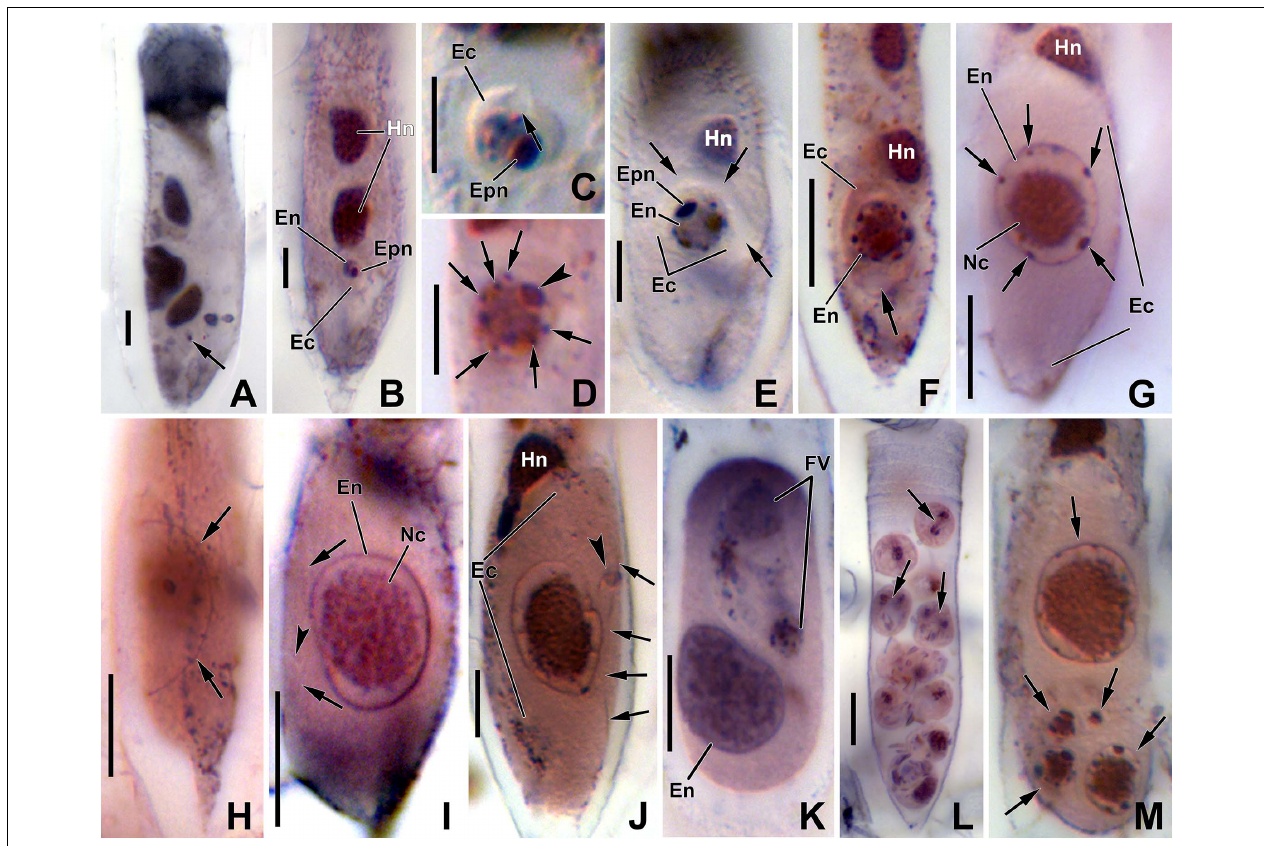
FIGURE 4 | Photomicrograph of Euduboscquella triangula after protargol impregnation. (A) Very early trophont (arrow) with conspicuous nucleolus. (B) Growth of early trophont. (C) Trophont showing opened vacuole toward the external environment (arrow). (D) Enlarged primary nucleolus (arrowhead) and small nucleoli beneath the nuclear envelope (arrows). (E) Parasitophorous vacuole between parasite and host cytoplasm (arrows). (F) Elongated trophont showing vacuolated appearance (arrow). (G) Nucleoli (arrows) being reabsorbed during late stage. (H) The shield with encircling perinema (arrows). (I) Very late trophont showing granular nucleoplasm without nucleolus and with shield (arrows) having an inconspicuous shallow indentation (arrowhead). (J) Lamina pharyngea (arrowhead) adjacent to the perimena (arrows). (K) Tomont with food vacuole. (L) Sporocytes showing mitosis (arrows). (M) Five infections (arrows) in single host. Ec, Euduboscquella cytoplasm; En, Euduboscquella nucleus; Epn, Euduboscquella primary nucleolus; Fv, food vacuole; Hn, host nucleus; Nc, nucleoplasm. Scale bars: (A–E) , 5 µ m; (F–L) , 10 µ